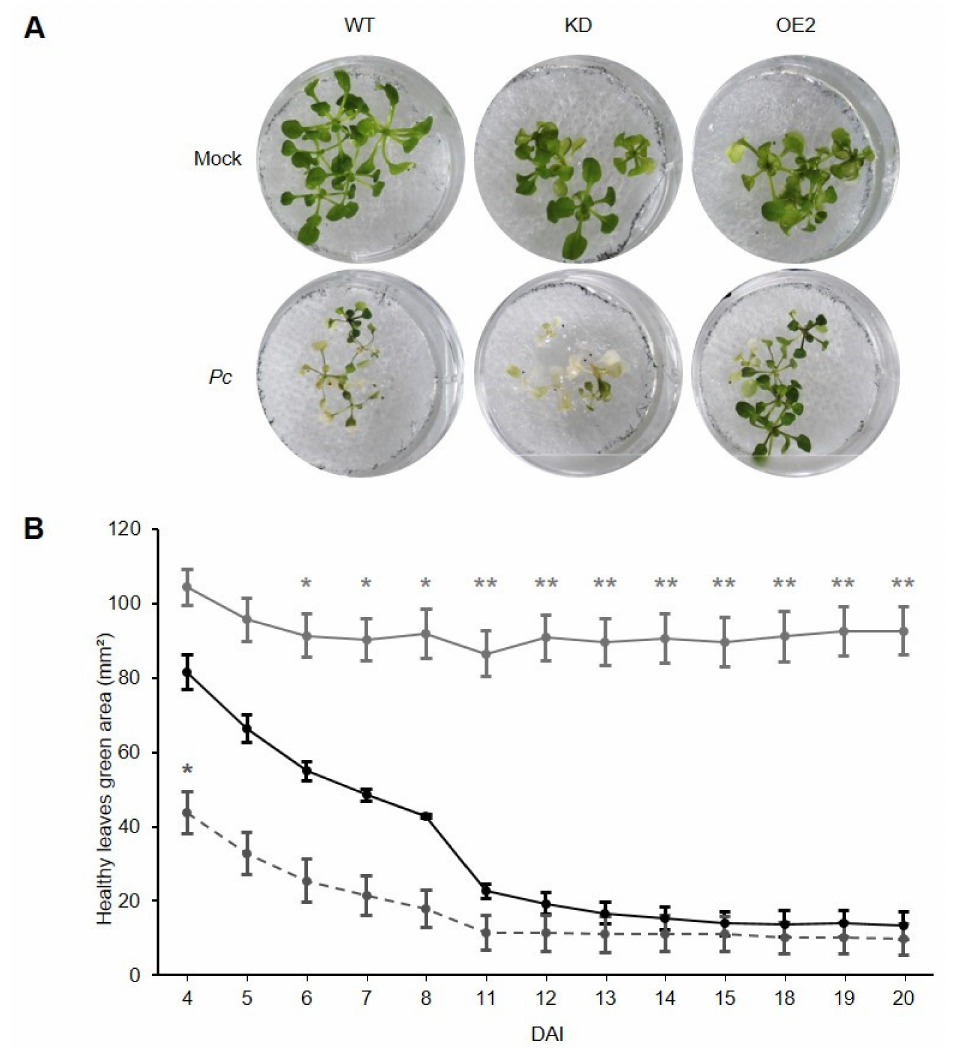
Figure 7. Comparative analysis of the susceptibility of CML8 genotypes upon Pc infection. Two weeks-old seedlings grown on liquid MS medium were inoculated with 10 3 zoospores from Pc LT3112 strain. ( A ) Photos represent the symptoms obtained at ten dai. ( B ) Quantification of disease was achieved by measuring the surface of green leaf area of inoculated plants from four to 20 days after inoculation. The solid black line, the dashed grey line and the solid grey line represent WT, CML8 KD and OE2 lines, respectively. The data presented correspond to three independent replicates. Bars = SEM. Statistical analyses were performed as described in Materials and Methods section and significant difference was found with p -values < 0.05 (** < 0.01, * <